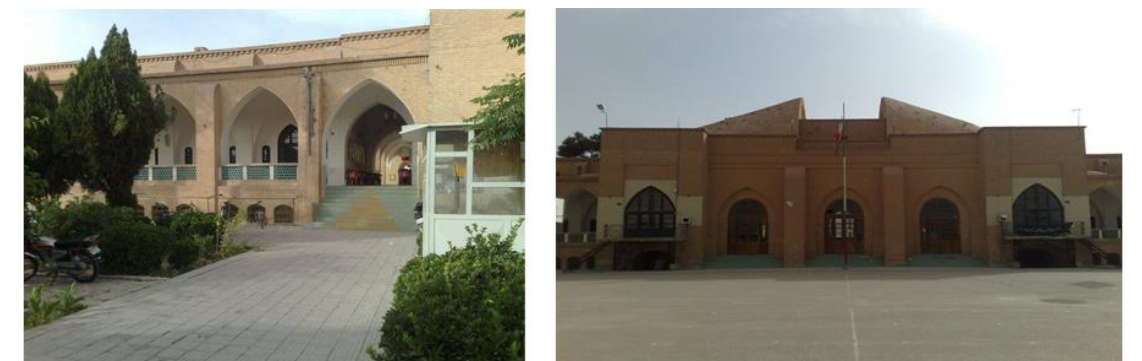
Figure 9 Traditional Factors in the Architectural Figure 10 The Façade of the Main Building of Iranshahr School Design of Iranshahr